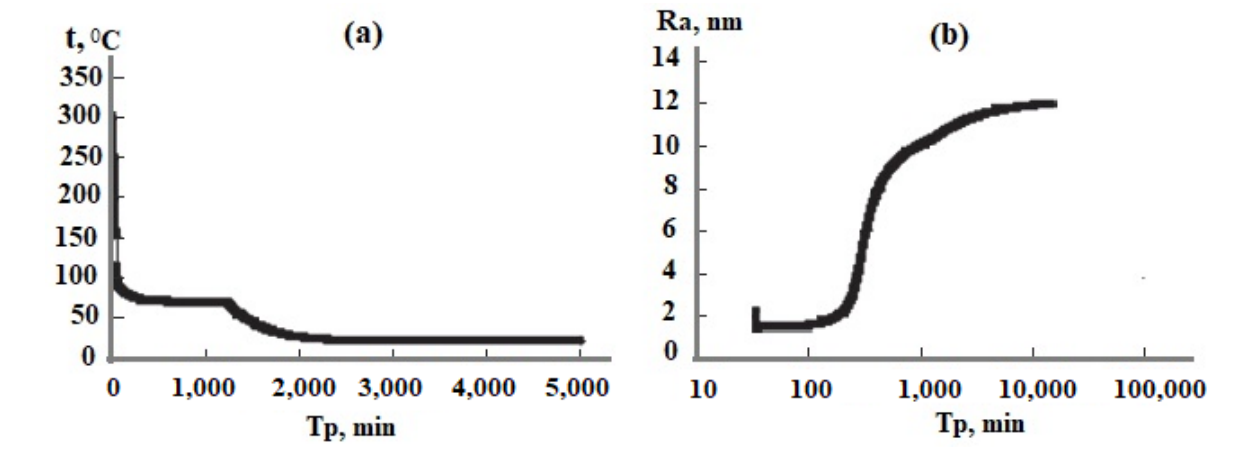
Figure 12. Parameters involved in the technological flow sheet of silica extraction. ( a ) Temperature versus time; ( b ) average silica particle radius as a function of time.